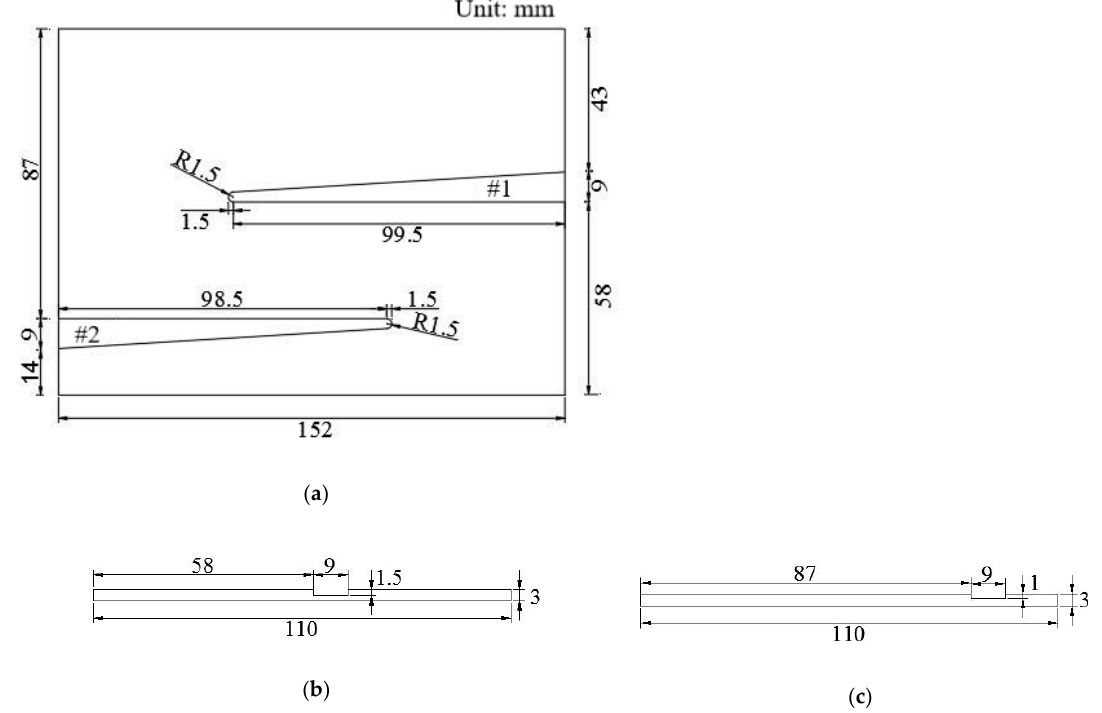
Figure 6. Schematics of PVC test specimen: ( a ) Main view: Distribution of defects; ( b ) Right View: Depth of defect #1; ( c ) Left View: Depth of defect #2.